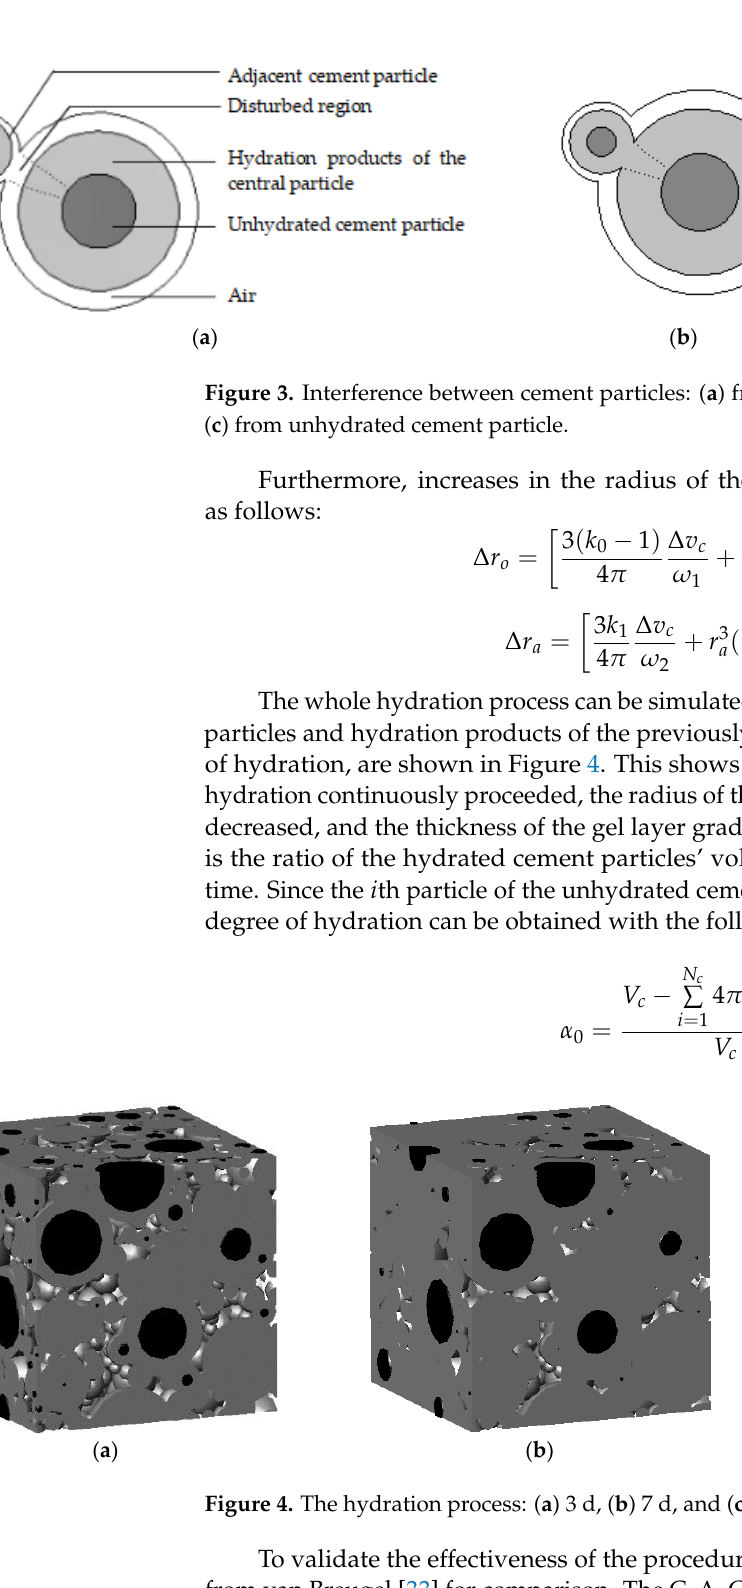
results were 7.7% and 0.7% at maintenance ages of 10 d and 28 d, respectively. When